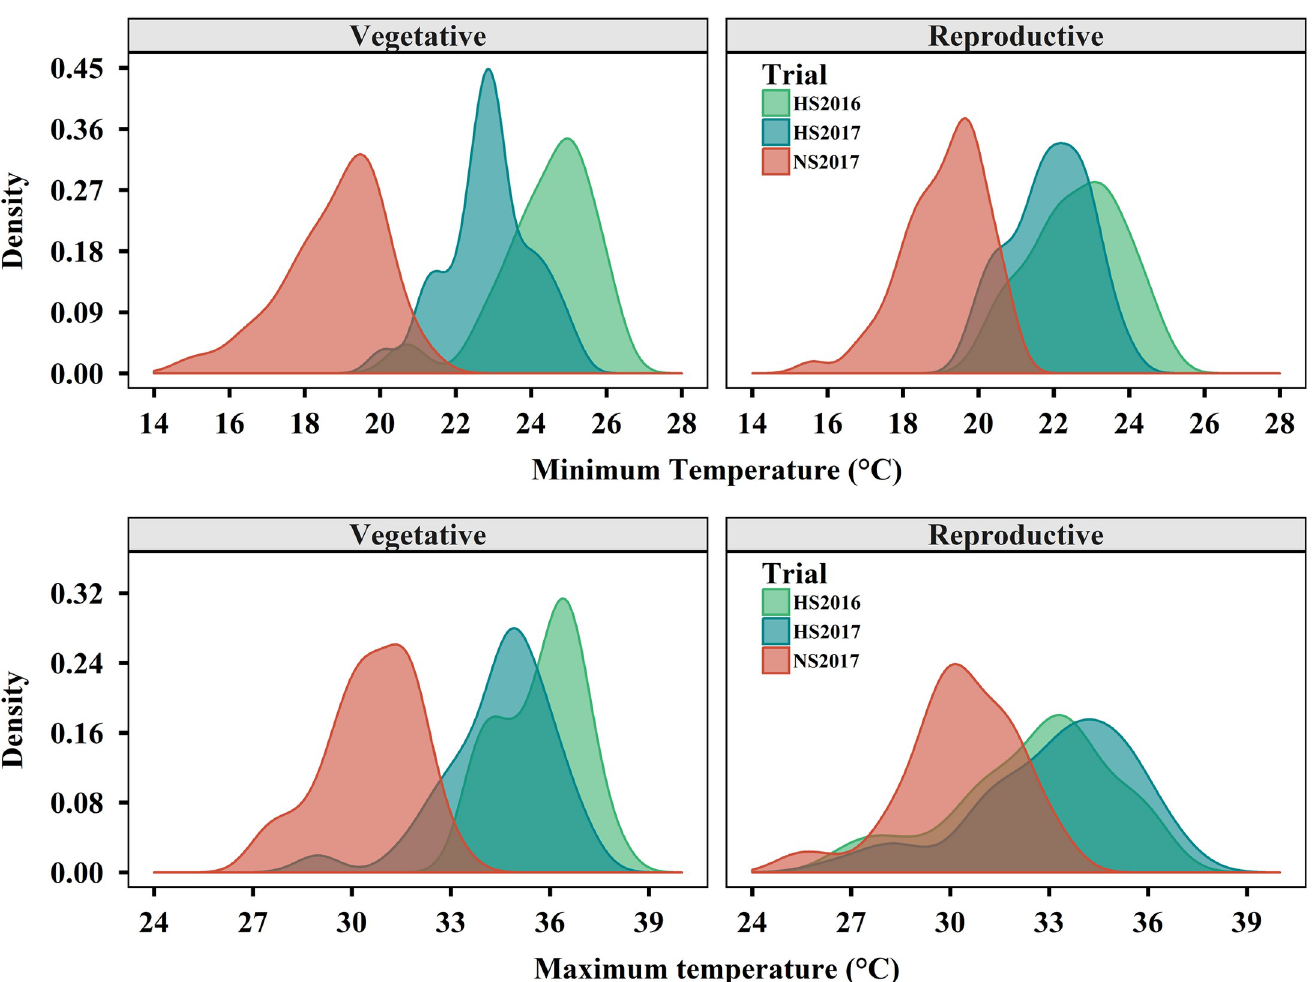
Fig 4. Distributions of maximum and minimum daily temperatures during vegetative and reproductive phases. Shown are the heat stress trials (HS) in Alvarado 2016/2017 and non-stress trial (NS) in Palmira